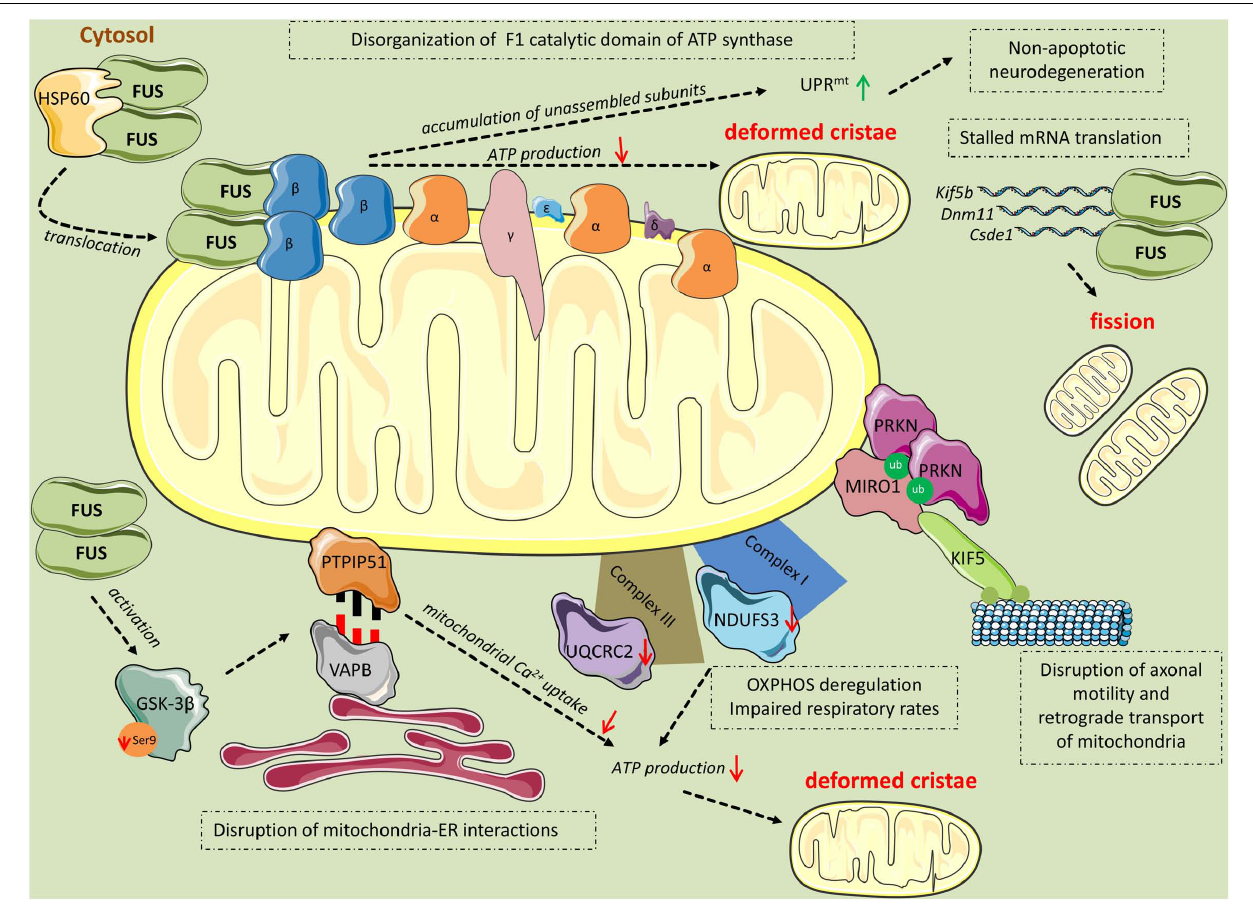
FIGURE 2 | Mitochondrial perturbations induced by FUS. HSP60 mediates FUS translocation to the outer mitochondrial membrane. Mitochondrial-localized FUS binds to the β subunit of the F1 catalytic domain of ATP synthase (Complex V). The binding leads to disassembly of the F1 domain and accumulation of unassembled ATP synthase subunits, including ATP5B, which activates the UPR mt response leading to non-apoptotic cell death. Additionally, disruption of the F1 domain of the ATP synthase complex results in impaired ATP production and thereafter, deformed cristae. FUS induces mitochondrial perturbations in several other manners while being in excess in the cytoplasm. Mutant FUS binds to mature mRNAs coding for important mitochondrial proteins including Kif5b , Dnm1l, and Csde1, inhibiting their translation. This inhibition progressively leads to mitochondrial fission. Excess FUS drives the accumulation of PINK1 and PRKN proteins. As a consequence, RHOT1, also known as Miro1, a component of the primary motor/adaptor complex that anchors kinesin to the mitochondrial surface and a direct target of PRKN, is ubiquitinated leading to disruption in axonal motility and retrograde transport of mitochondria. Additionally, FUS has an impact on the OXPHOS process by deregulating the expression of the subunits NDUFS3 and UQCRC2 of Complexes I and III, respectively. OXPHOS deregulation leads to respiratory impairment and subsequent ATP production deterioration and deformed cristae. Finally, FUS decreases the levels of ser9 phosphorylation in GSK-3 β , leading to increased GSK-3 β activity. Activated GSK-3 β deregulates the interaction of mitochondrial tethered membrane protein PTPIP51 and the inner protein of the ER, VAPB, disrupting mitochondria-ER associations. The ER-mitochondria disruption decreased Ca 2 + uptake by mitochondria following release from ER stores, resulting in reduced ATP production and deformed